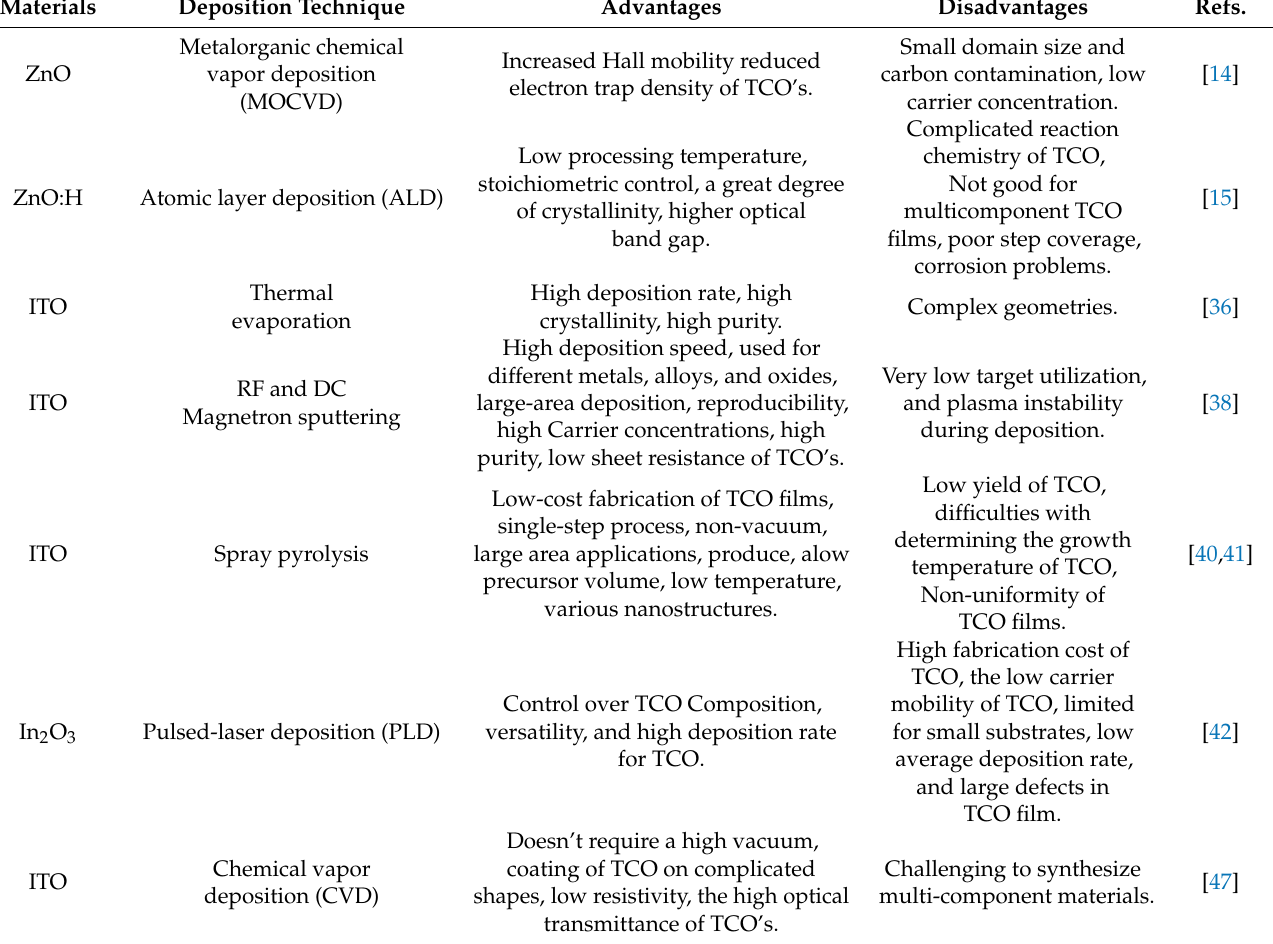
Table 1. The deposition of ITO thin films by various techniques, along with the advantages and disadvantages of each